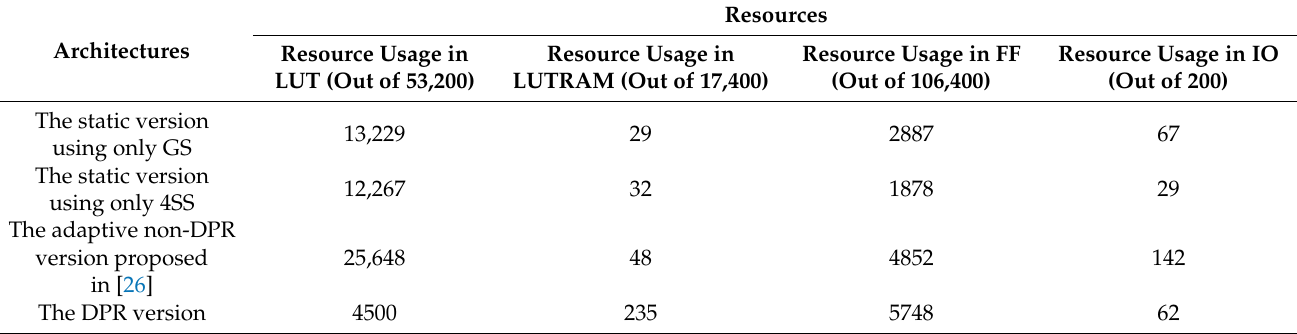
Table 2. Comparison between the static and reconfigurable watermarking systems in terms of